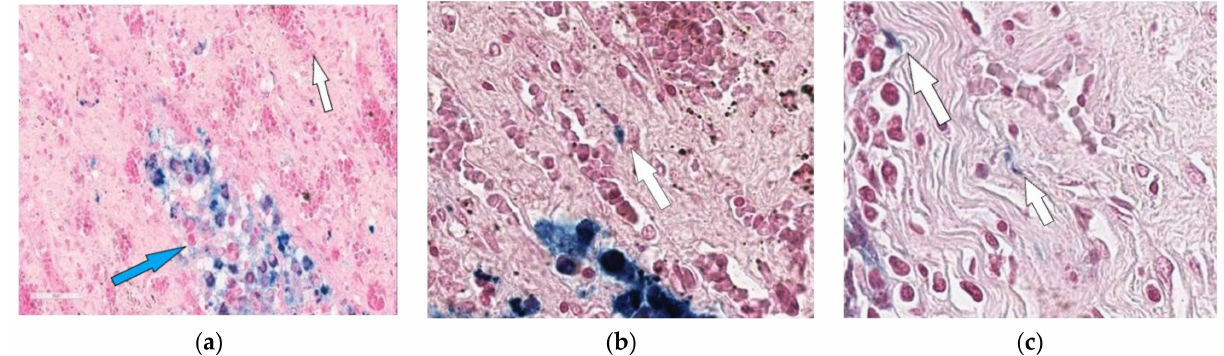
Figure 6. Kidney of the rabbit that received MSCs after completion of 3-month anti-tubercular chemotherapy (one month after MSC transplantation). Accumulation of hemosiderophages (indicated by blue arrow) in the renal parenchyma ( a ) and cells with Perls-positive inclusions vessels (indicated by white arrow) in the walls of small ( b , c ). 400 × .